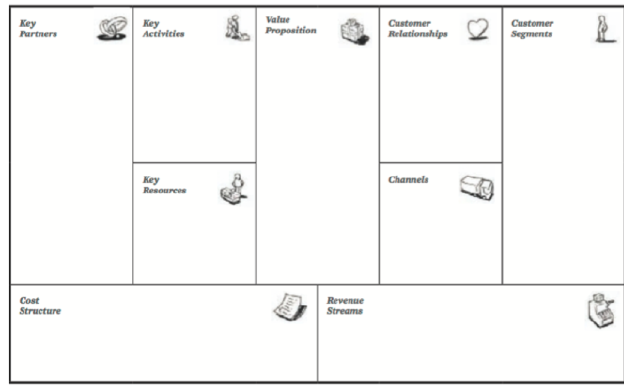
Figure 1: Business Model Convas; Source: Osterwalder & Pigneur, 2010: 18-19